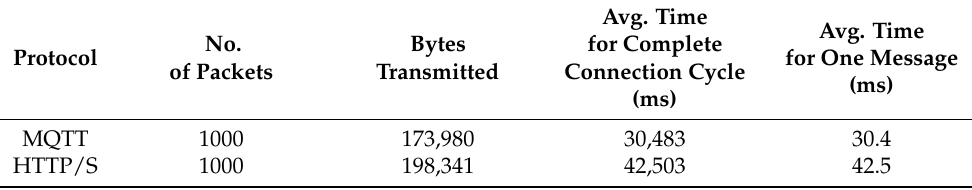
Table 2. MQTT vs.